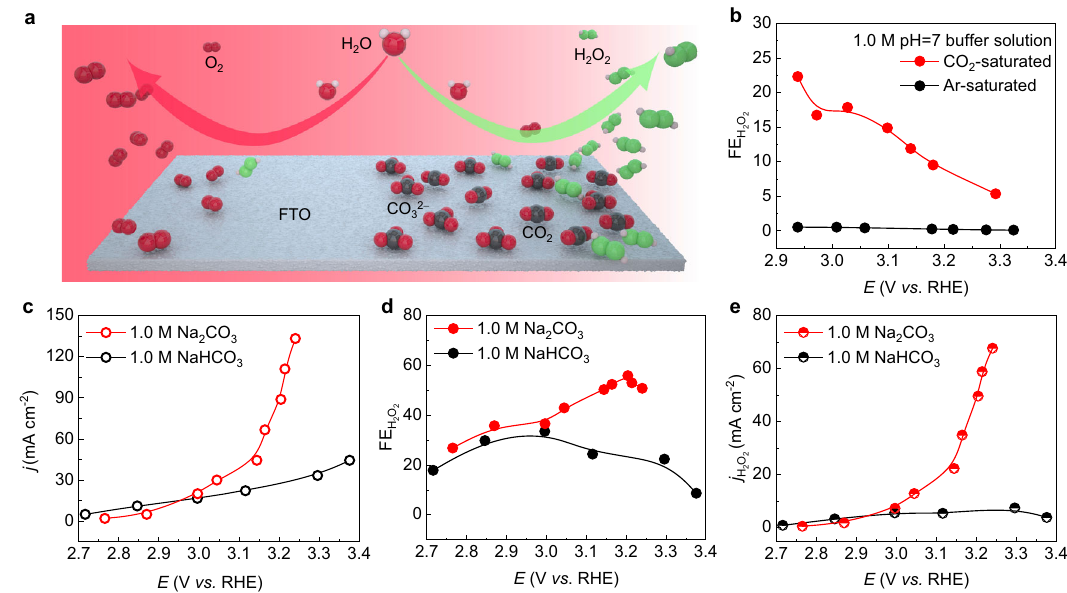
Fig. 1 CO 2 /Carbonate promotion effects in 2e − -WOR. a Schematic illustration of CO 2 /carbonate promoted electrochemical H 2 O oxidation to H 2 O 2 . With the mediator effects of CO 2 /carbonate, the WOR reaction pathway could change from 4e − towards O 2 to 2e − towards H 2 O 2 . b H 2 O 2 selectivity in Ar- saturated and CO 2 -saturated 1.0 M sodium phosphate buffer solution. CO 2 serves as a promoter for 2e − -WOR, as the H 2 O 2 selectivity increased by orders of magnitude compared to that without CO 2 . c – e I – V curves, H 2 O 2 FEs, and H 2 O 2 partial current densities in 1.0 M NaHCO 3 and 1.0 M Na 2 CO 3 , respectively. The maximum H 2 O 2 FE in 1.0 M NaHCO 3 was 34% with a H 2 O 2 partial current density of 5.6 mA cm − 2 . In comparison, the maximum H 2 O 2 FE in 1.0 M Na 2 CO 3 was 56%, and the maximum H 2 O 2 partial current density was 68 mA cm − 2